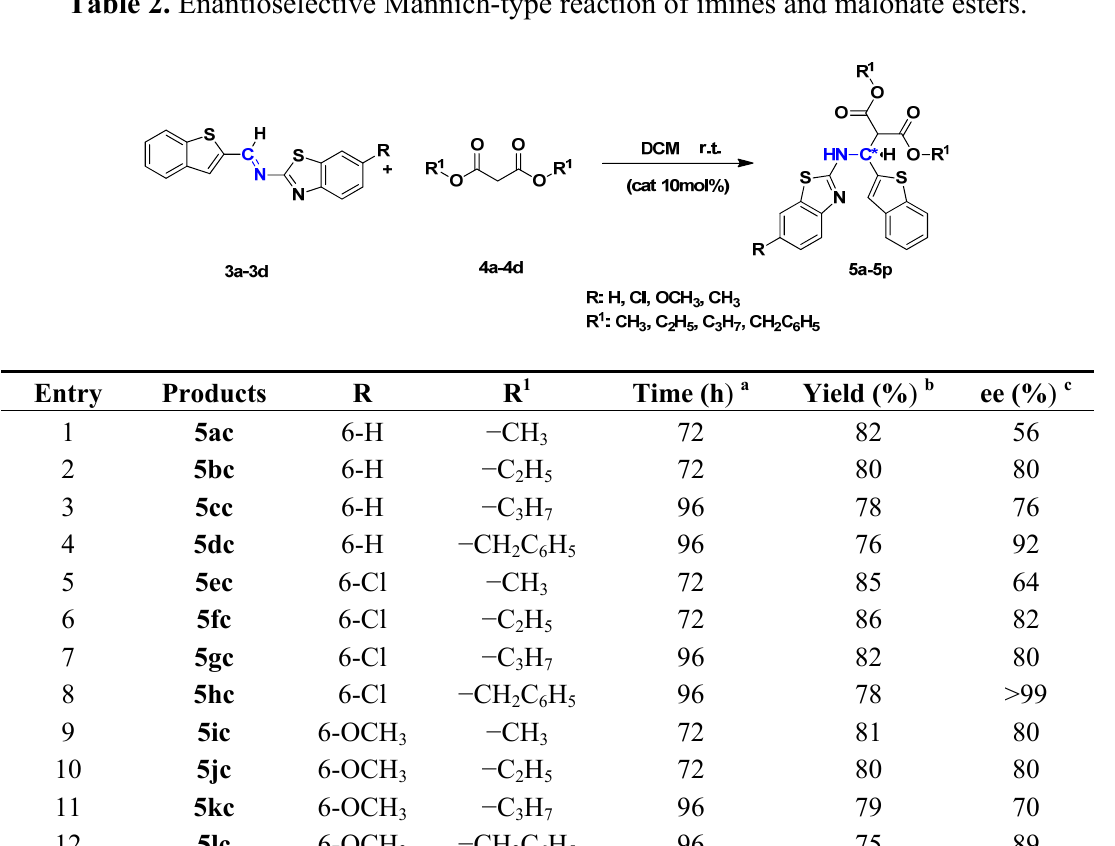
Table 2. Enantioselective Mannich-type reaction of imines and malonate